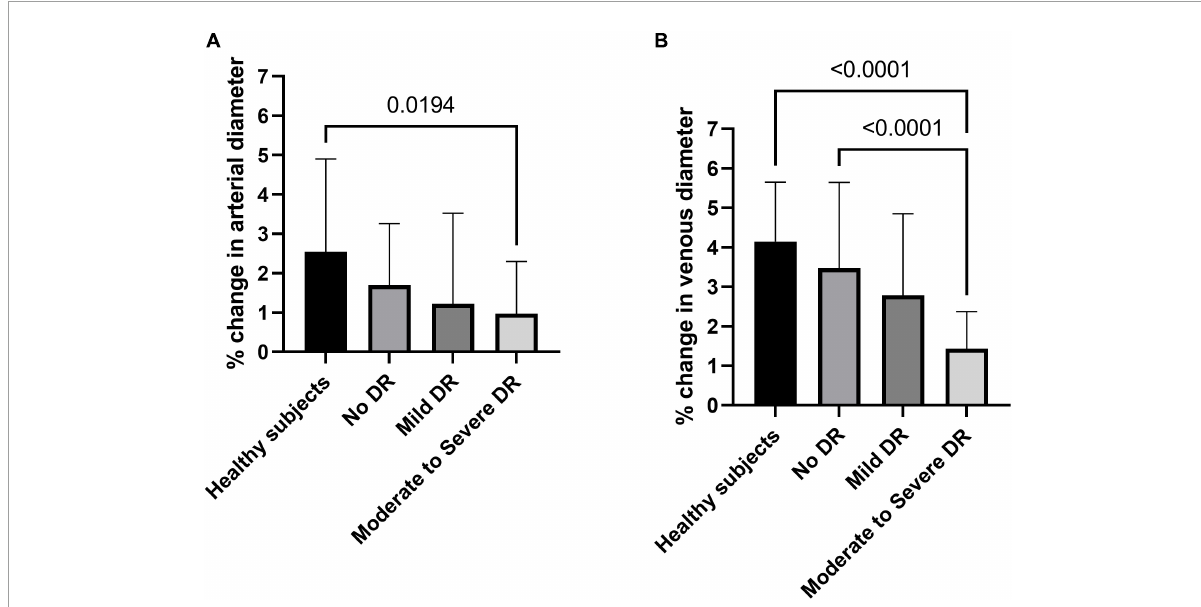
FIGURE2 Flicker response of retinal arterial (A) and venous (B) diameter in healthy subjects, patients with no diabetic retinopathy (no DR), mild diabetic retinopathy (mild DR), and moderate to severe diabetic retinopathy (moderate to severe DR). Data are presented as mean ± SD. Planned comparisons were used to calculate p -values between groups.